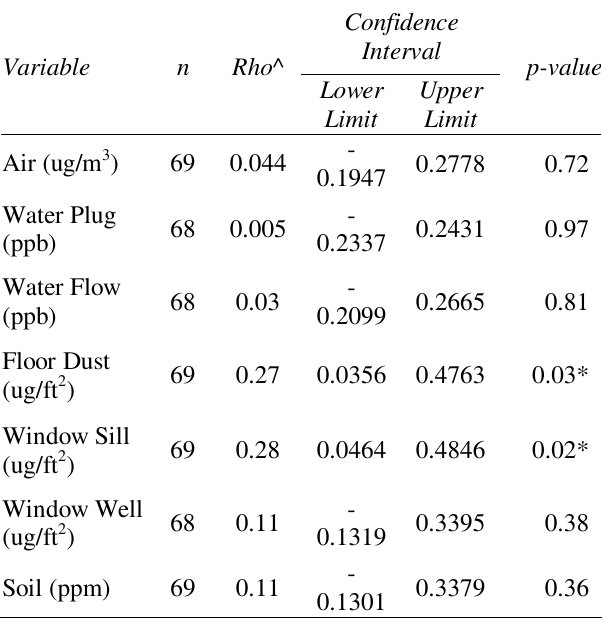
Table 4: Correlations between Blood Lead Levels and Environmental